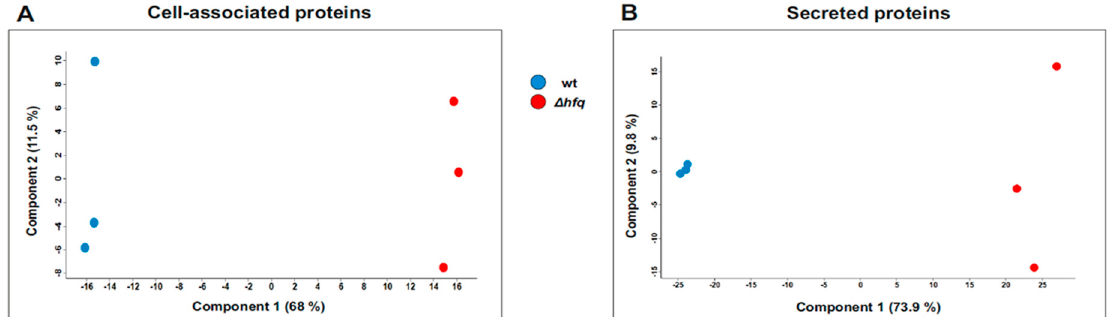
Figure 3. Principal component analysis (PCA) of proteomic samples. PCA was applied to protein profiles of the wt strain (blue circles) and Δ hfq mutant (red circles) determined in corresponding cell-associated ( A ) or secreted ( B ) protein fractions. Each dot represents an independent biological replicate.